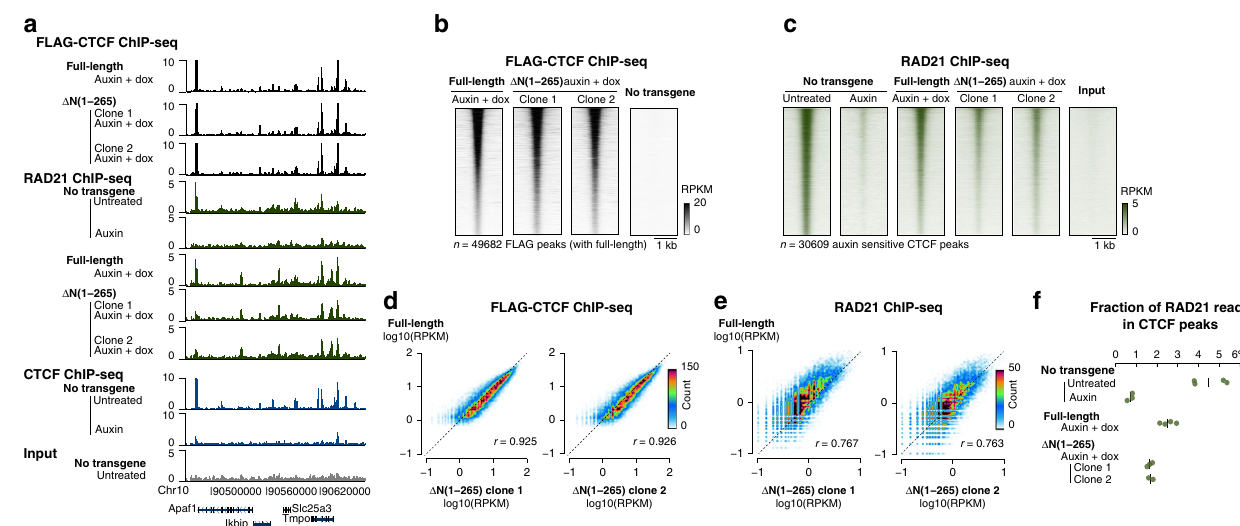
Fig. 3 The CTCF N terminus participates in but is not strictly required for cohesin positioning at CTCF sites. a ChIP-seq track snapshot, b , c density plots, d , e scatterplots, and f fraction of reads in peak (FRIP) scores indicates that RAD21 is still detected at CTCF peaks 3 in cells expressing CTCF Δ N (1 – 265), albeit with a twofold reduced enrichment compared to the full-length CTCF transgene. CTCF ChIP-seq data were obtained from ref. 3